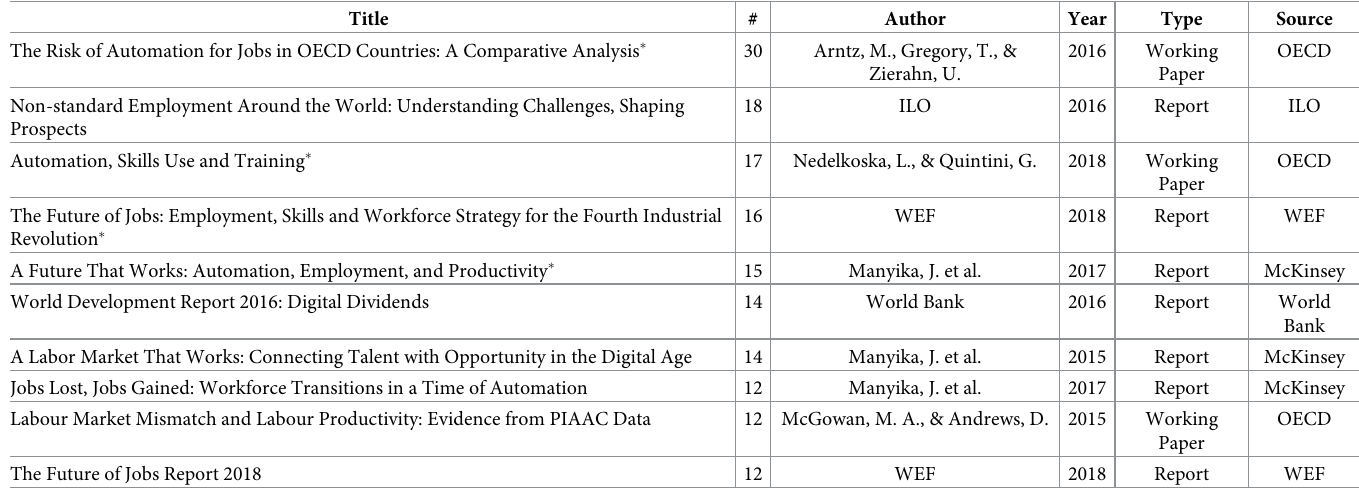
Table 6. Most frequently referenced grey